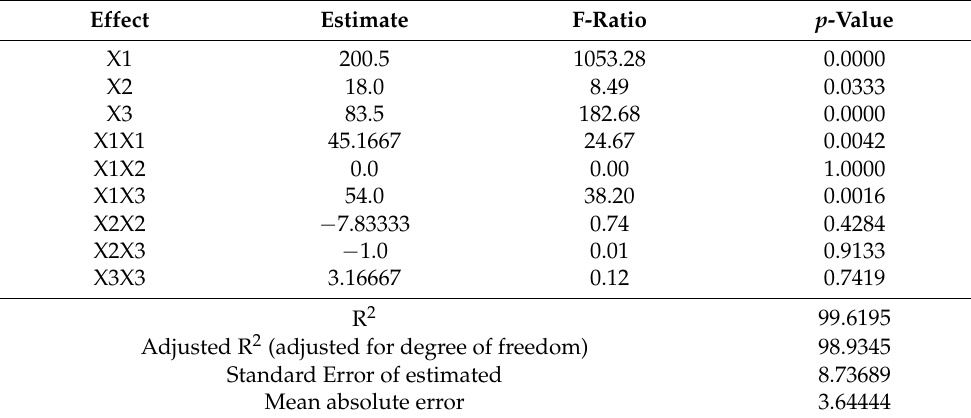
Table 2 depicts the statistical analysis of variance of response data, i.e., particle size. Table 2. Statistical analysis of variance (ANOVA) of the responses (particle size). Effect